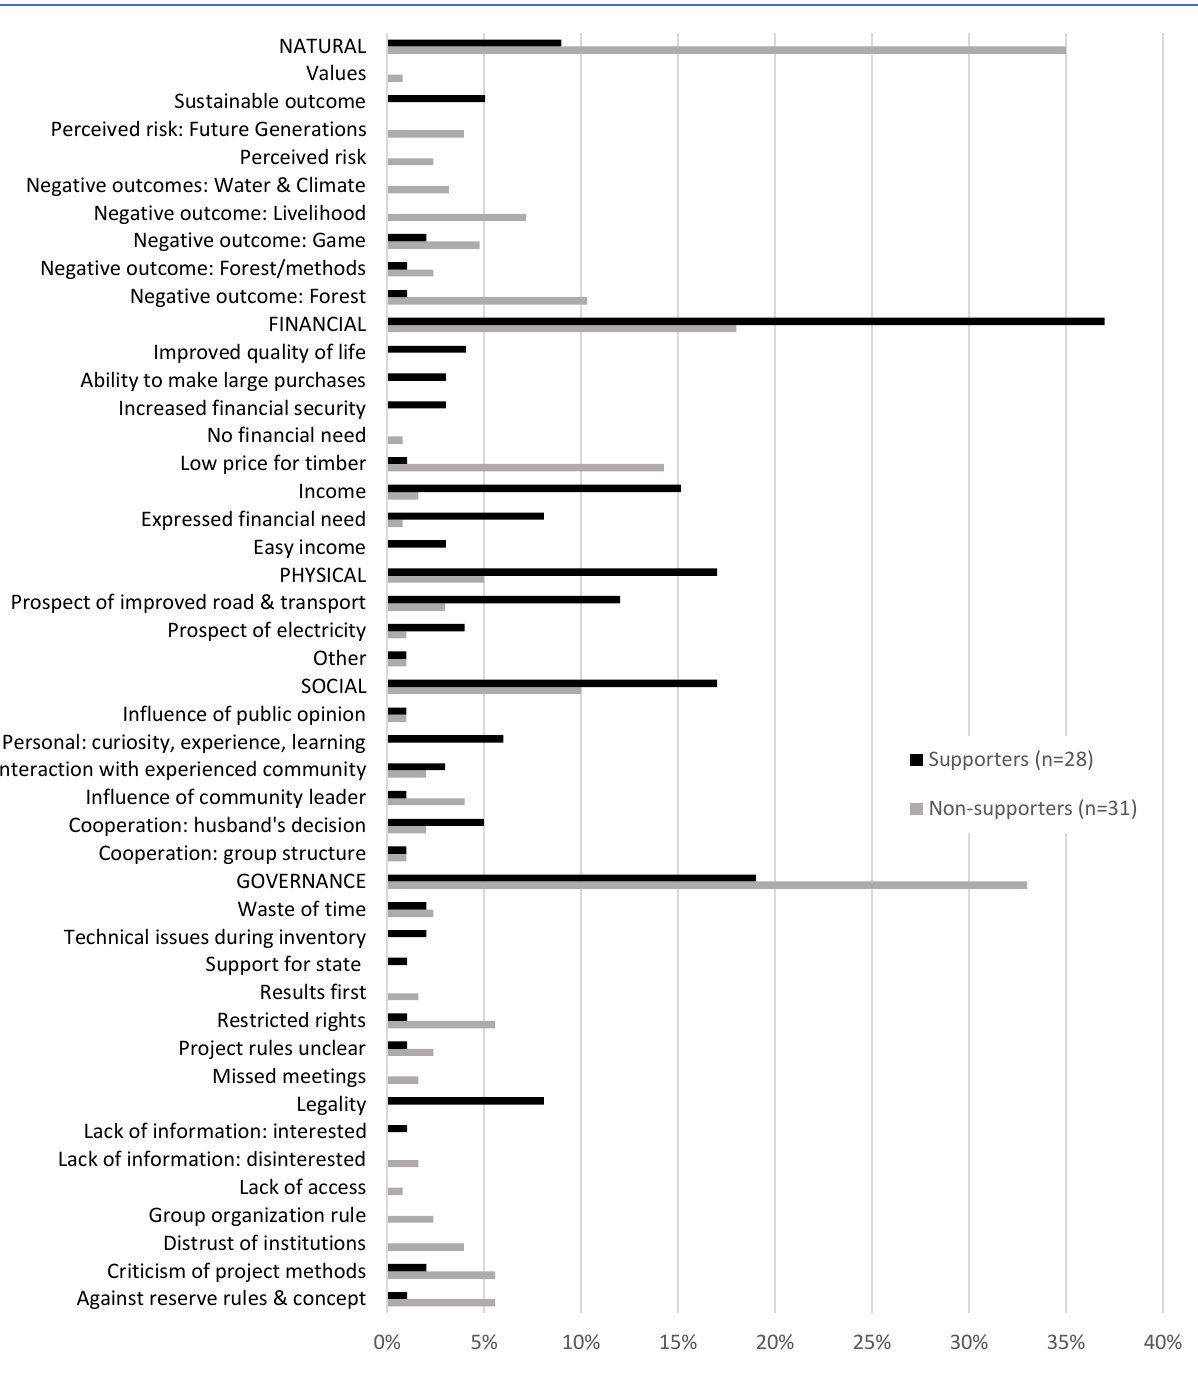
Fig. A4.1. Graph of five categories (Natural, Financial, Physical, Social, and Governance) with subcategories of reasons for participation or non-participation in the logging project, Chico Mendes Extractive Reserve, Brazil,